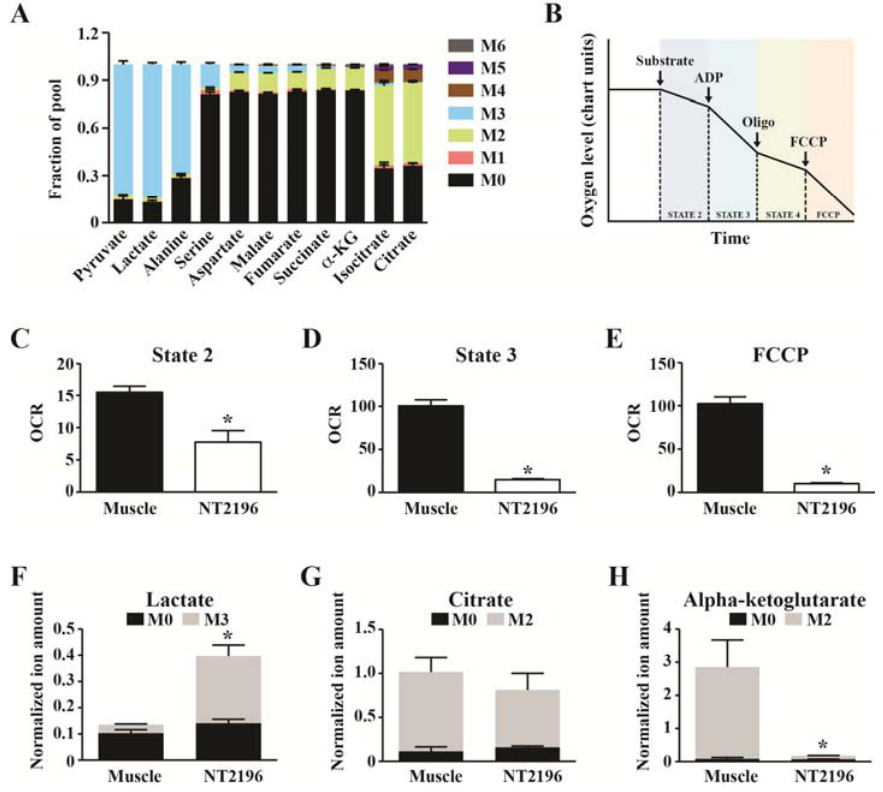
Figure 4. Stable isotope tracer analyses of cells and isolated mitochondria from mammalian systems. ( A ) Mass isotopomer analyses of metabolites extracted from NT2196 cells incubated with 10 mM U- 13 C-glucose for 1 h. M0 to M6 represent the m + 0 to m + 6 enrichments and are indicated by different colors. Data are shown as means  SEM of five independent experiments. ( B ) The experimental design for respiration analyses in isolated mitochondria. The addition of substrates/drugs to isolated mitochondria is indicated by arrows above the trace. The addition of ADP stimulates ATP production. Oligomycin inhibits ATP synthase and thus, respiration coupled to ATP production, and FCCP (carbonyl cyanide- 4 -(trifluoromethoxy) phenylhydrazone) uncouples respiration from ATP production, representing the maximal respiratory capacity of mitochondria. ( C–E ) Comparison of State 2 ( C ), State 3 ( D ) or FCCP ( E ) rates in isolated mitochondria from murine skeletal muscle and NT2196 cells. Oxygen consumption rate (OCR) is the rate of oxygen consumption (chart units) normalized per minute per mg of mitochondrial protein, where 1 chart unit is 0.2% oxygen. Data are shown as means  SEM of 4 independent experiments for NT2196 cells and 10 for muscle tissue. * p < 0.05, Student’s t -test. ( F–H ) Isotopic enrichment for lactate ( F ), citrate ( G ) and alpha-ketoglutarate ( H) in isolated mitochondria from murine skeletal muscle and NT2196 cells incubated with U- 13 C-pyruvate and unlabeled malate for 30 minutes at 37 °C. Data are shown as means  SEM of 4 independent experiments. * p < 0.05, Student’s t -test. “Normalized ion amount” is used to define the values obtained from the MID × corrected area (Section